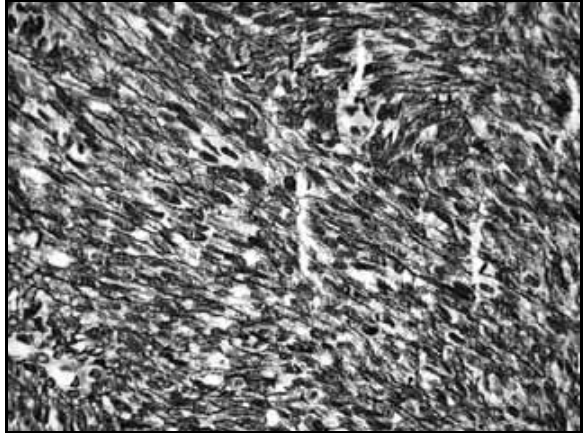
Figura 3 – Deposição de reticulina pericelular (Reticulina, 400×)